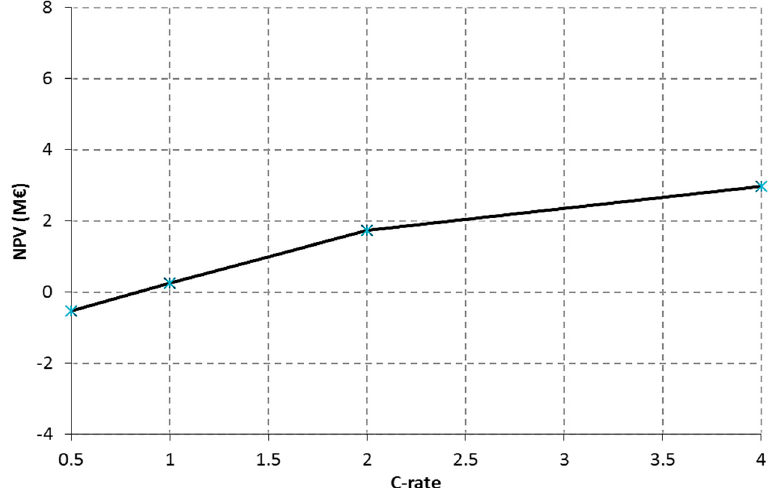
Figure 14. Estimated NPV for a 1 MWh BESS, for different C-rates (0.4% droop, capacity-based PFC market).